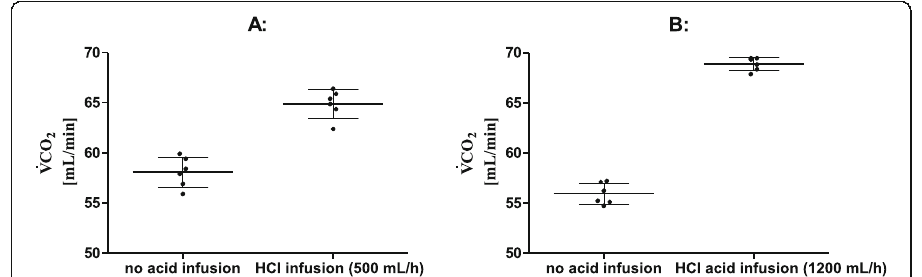
Fig. 4 Acidification of recirculated blood. Acidification of blood in the recirculation channel leads to a significantly increased CO 2 removal. a ˙ V Sweep of 5 L/min, simulated cannula flow of 260 mL/min, recirculation flow of 180 mL/min, and HCl infusion rate of 500 mL/h. b ˙ V Sweep of 5 L/min, simulated cannula flow of 290 mL/min, recirculation flow of 170 mL/min, and HCl infusion rate of 1200